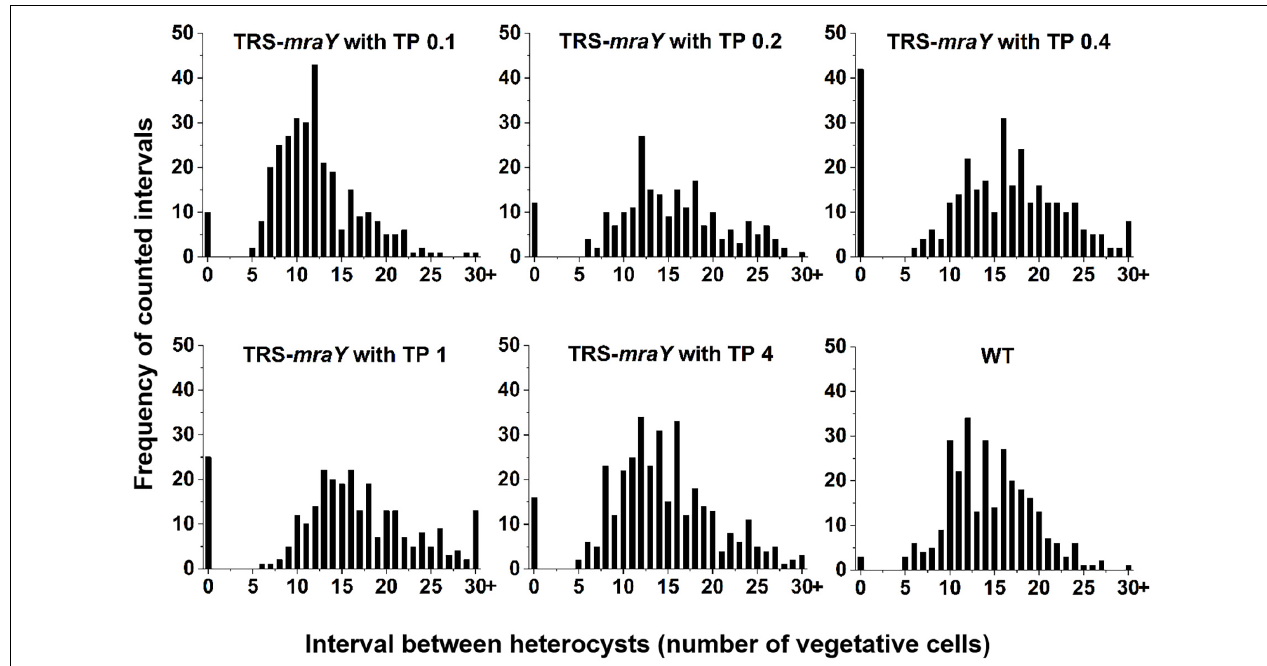
FIGURE 8 | Heterocyst pattern in WT and TRS- mraY mutant. The same cultures as used in Figure 7A , at 48 h after transfer to BG11 0 , were analyzed. The frequency of intervals (number of vegetative cells between two heterocysts) is shown. When the interval is 0, it corresponds to double heterocysts as indicated in Figure 7 . 350–450 heterocysts were counted for each condition. TABLE 2 | Percentage of aberrant heterocysts of strain TRS- mraY grown in BG11 0 medium. Strains and conditions (TP: